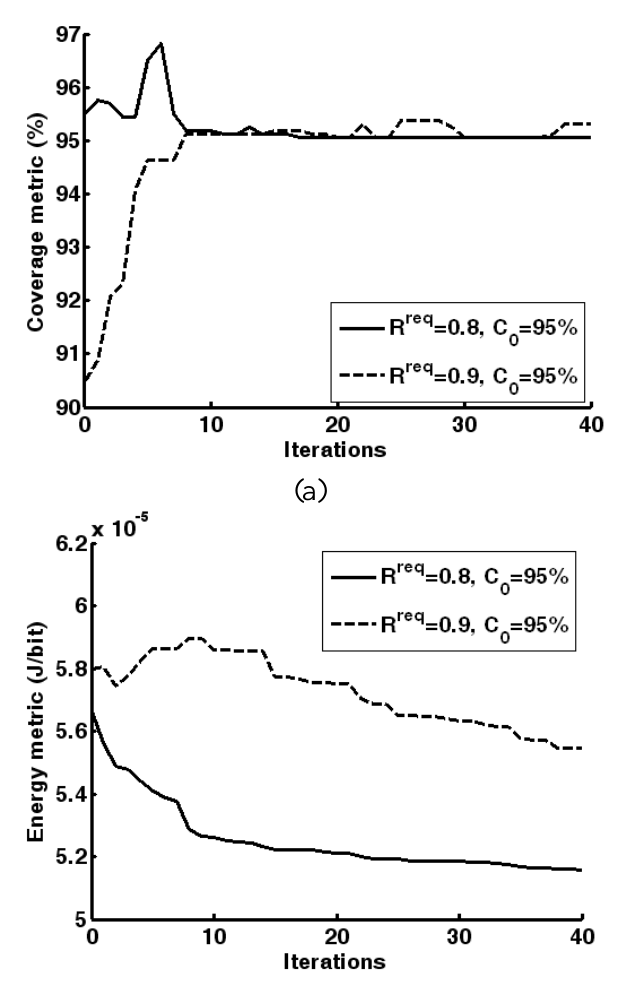
Figure 5. Convergence curves of the metrics under two kinds of coverage requirement during DPSOSA: (a) Coverage metric; (b) Energy